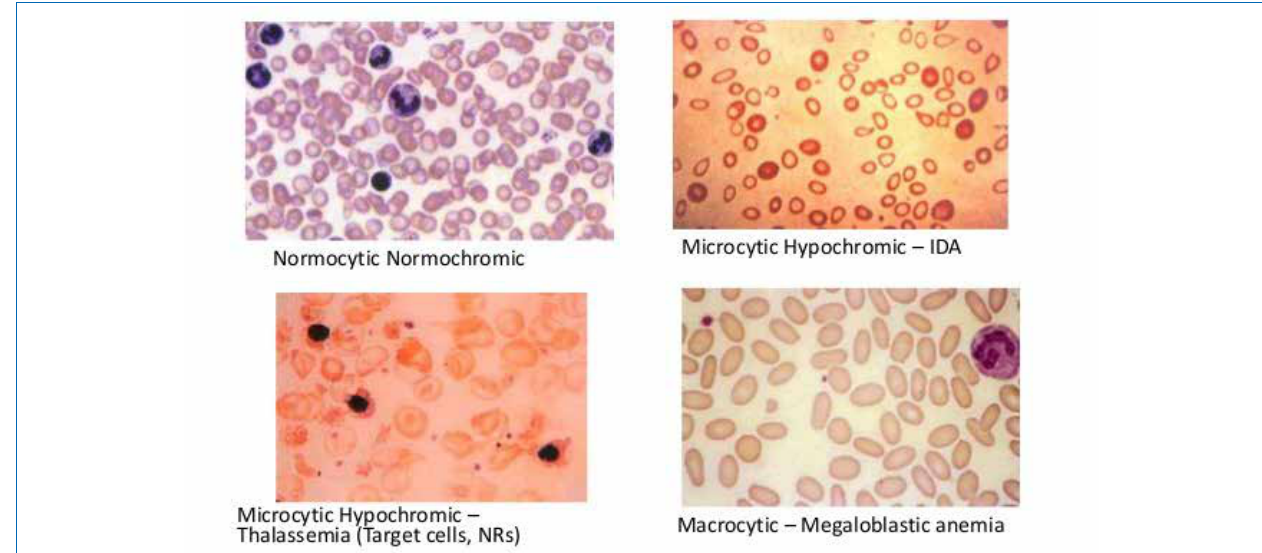
Figure 4. Anaemia can also be classified based on the size of red blood cells (Courtesy: http://www.australianhospitals.net/anemia/how-to-treat-microcytic-anemia. Accessed 13 April